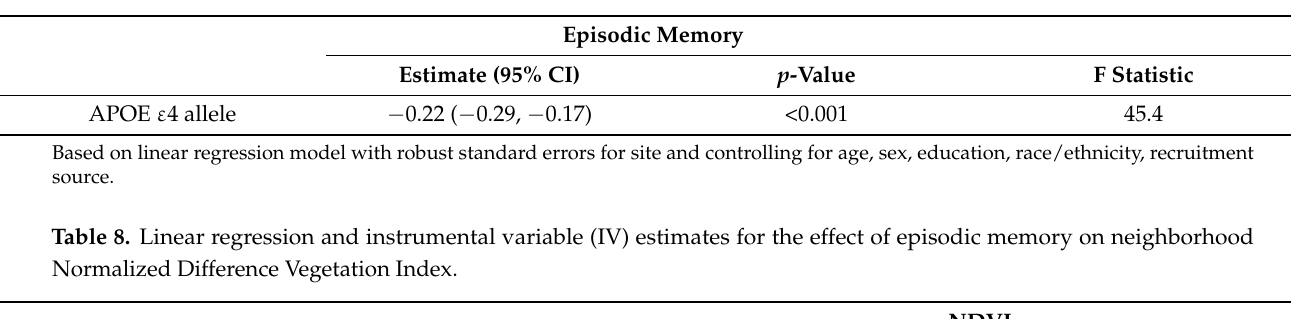
Table 7. 1st Stage regression results for strength of APOE genotype as an instrument for episodic memory.